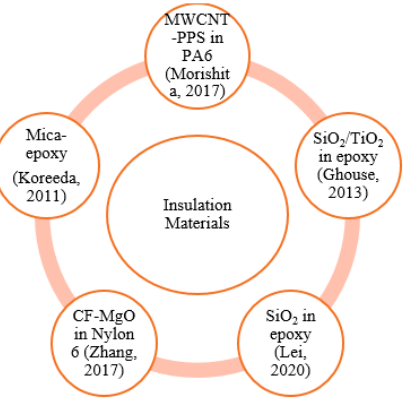
Figure 6. A survey of different materials used for insulation in electric machines.